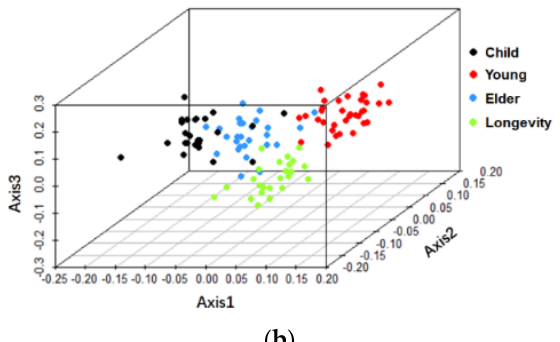
Figure 9. Canonical analysis of principal coordinates (CAP) based on high ‐ throughput sequencing data of the groEL gene of Bifidobacterium . ( a ) CAP of Bifidobacterium composition of different region groupss. ( b ) CAP of Bifidobacterium composition of different age groups.